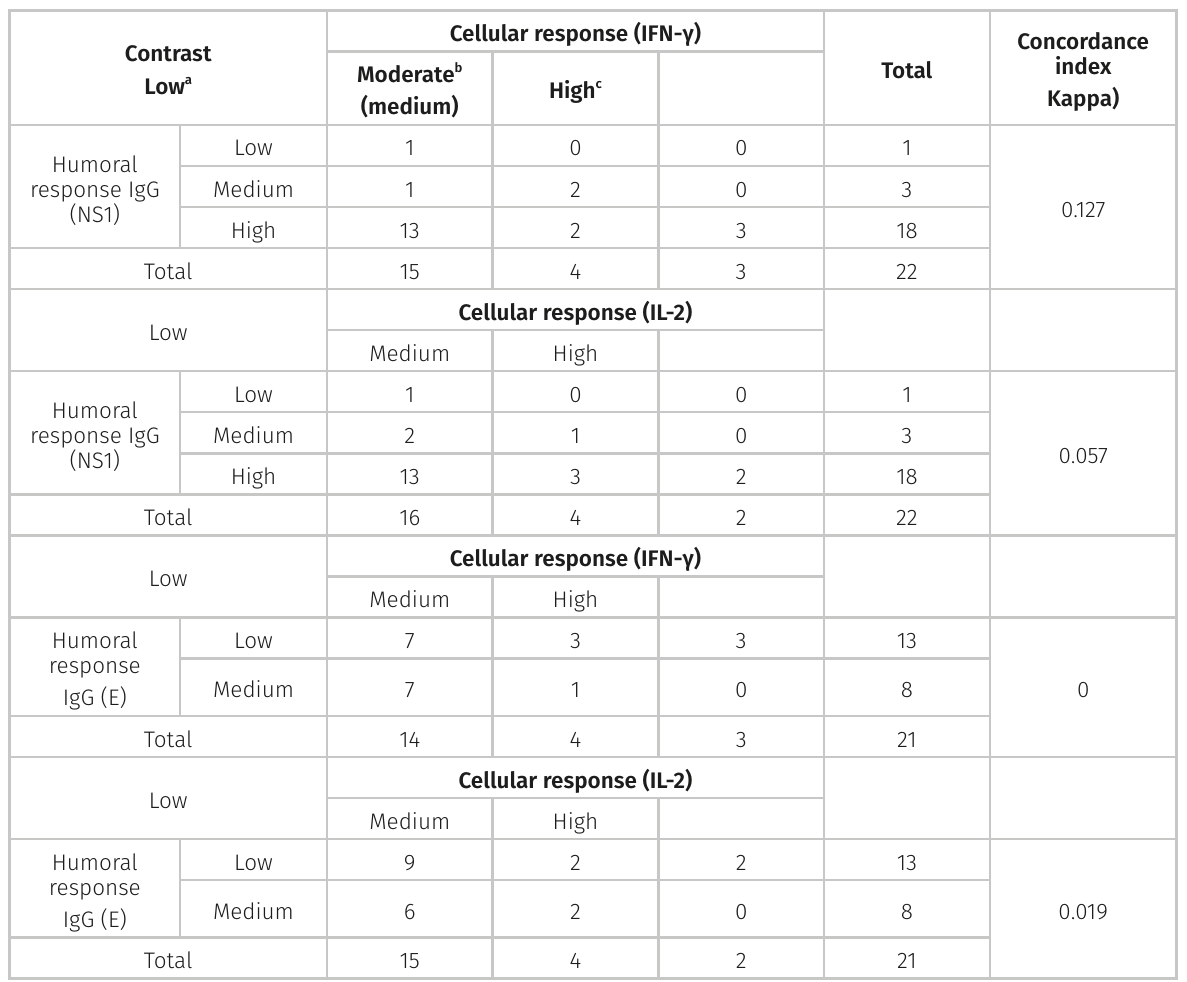
Table III. Humoral and cellular response magnitude concordance analysis.